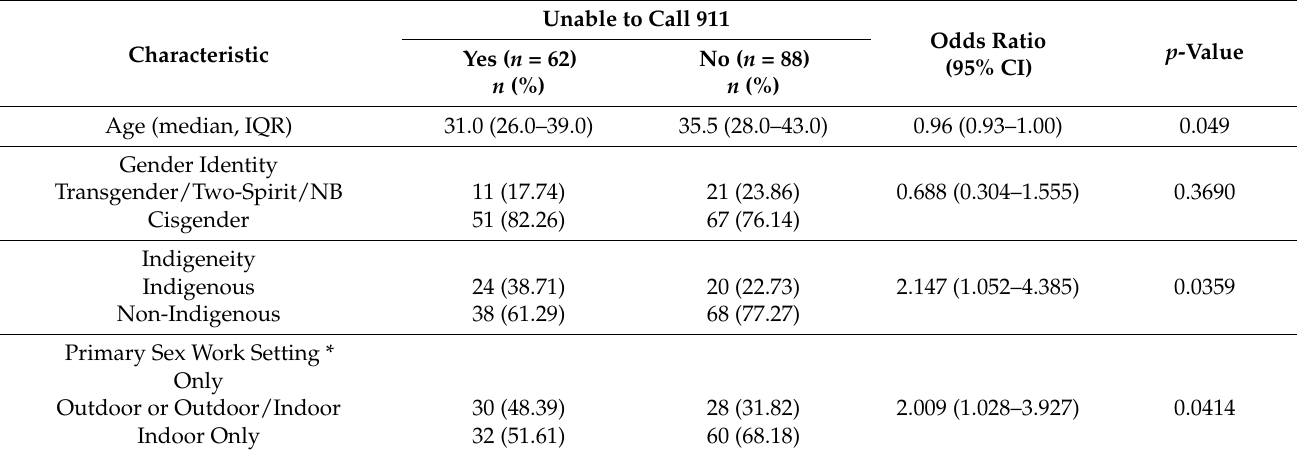
Table 1. Characteristics and unadjusted odds ratios associated with sex workers being unable to call 911 in a safety emergency due to fear of police